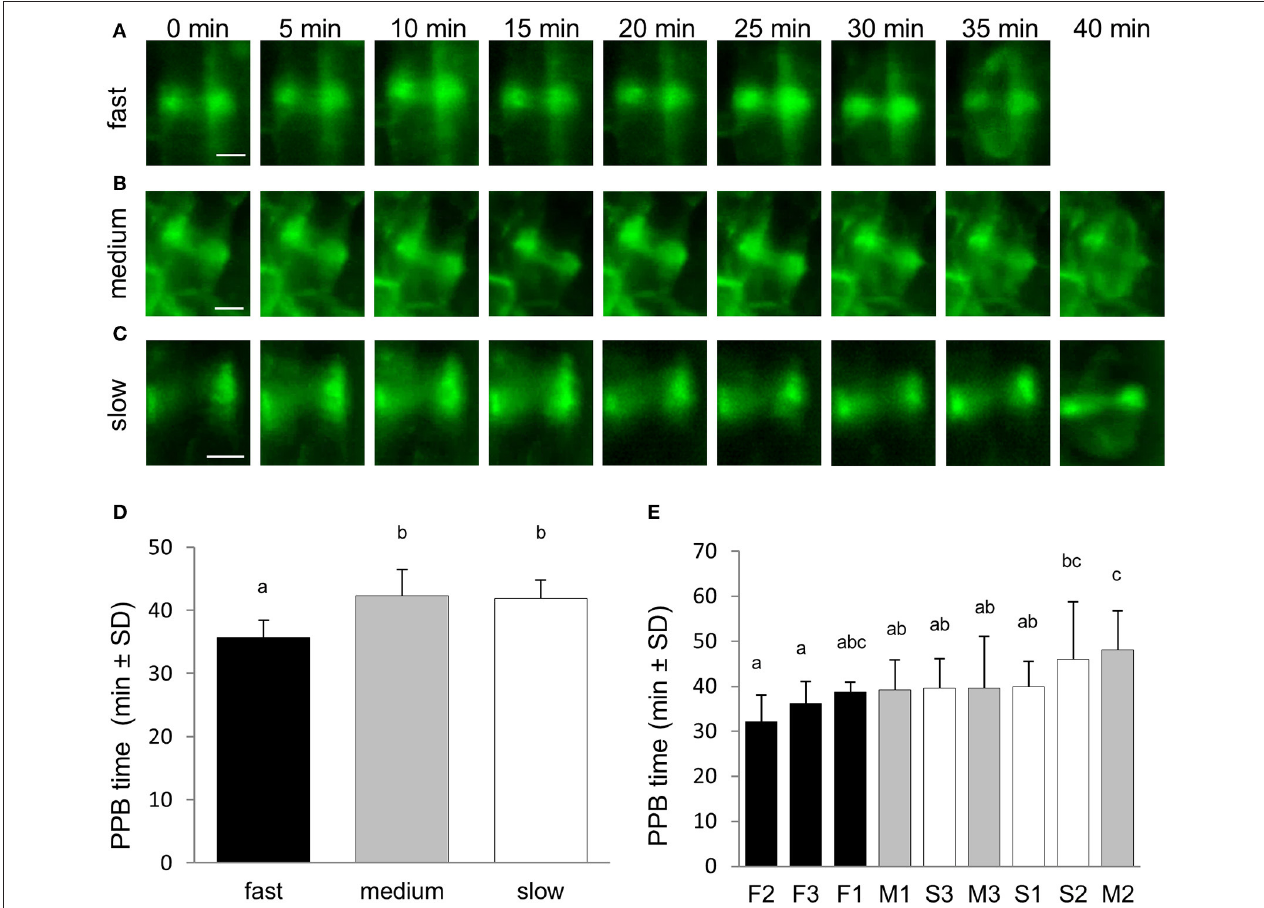
FIGURE 3 | Duration of the preprophase and prophase stage of the cell division. (A–C) Series of stills from time-lapse light-sheet imaging of dividing cells in root epidermis and cortex of M. sativa plants expressing 35S::GFP:MBD construct. Sequence of preprophase and prophase stage starting from PPB narrowing and finishing by last stage of PPB presence and early mitotic spindle formation. Progress of the preprophase and prophase stage is shown for fast-growing roots (A) , medium-growing roots (B) , and slow-growing roots (C). Series of images were recorded in 5min intervals from the stage of cell division when progressive PPB narrowing was defined by PPB width in the range of 2–4 µ m (time 0min). (D) Average duration time of preprophase and prophase stage of cell division in all roots of fast-growing, medium-growing and slow-growing group of roots. (E) Average duration time of preprophase and prophase stage in all dividing cells of individual roots. Roots are arranged from shortest to longest average duration time of preprophase and prophase stage. Black bars represent fast-growing roots (F1, F2, F3), gray bars represent medium-growing roots (M1, M2, M3) and white bars represent slow-growing roots (S1, S2, S3). Different letters above the bars represent statistical significance according to one-way ANOVA test at P < 0.05. Bars = 5 µ m (A–C)